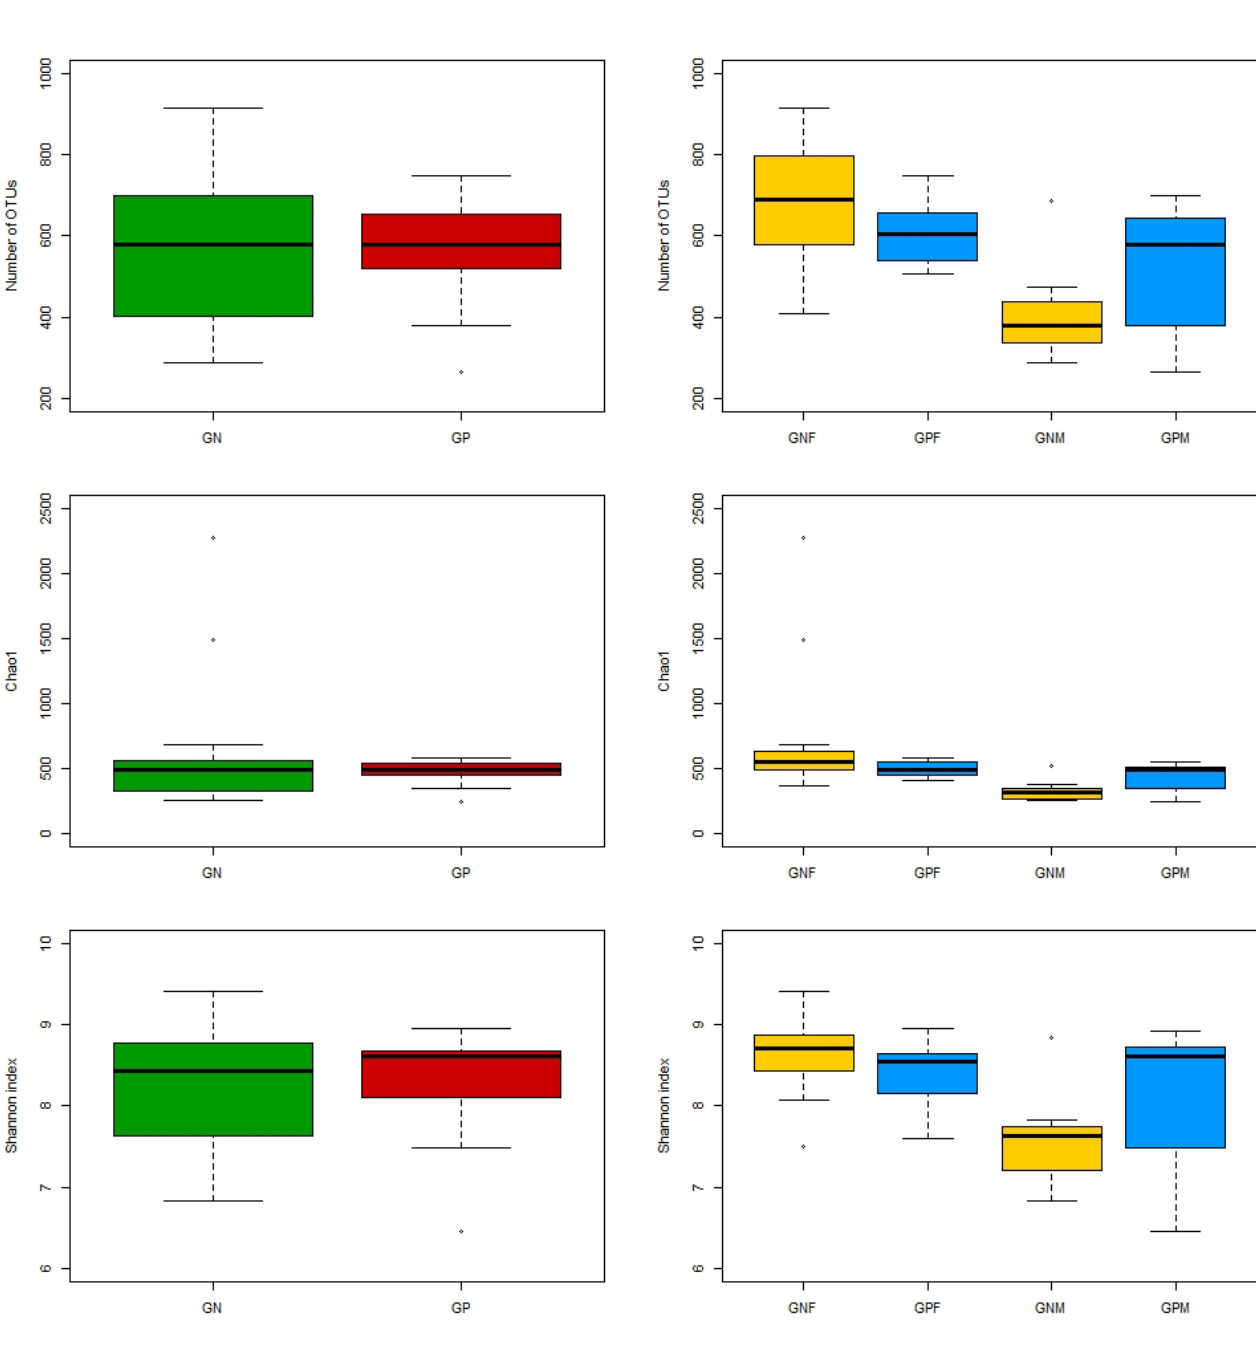
Figure 1. Box plot of the number of identified OTUs and Alpha-diversity (Chao1 and Shannon indices) by groups of study: GP and GN; GPF, GPM, GNF, and GNM. The box plot synthesize the data, providing the principal measures of central tendency and dispersion. Specifically, the diagram comprises a box with horizontal limits defining the upper and lower quantiles representing the interquartile range, with the median marked by a horizontal line within the box. The whiskers are vertical lines extending from the box as low as the 2.5th percentile and as high as the 97.5th percentile. Extreme values are indicated by dots. Table 1. unique OTUs per group.